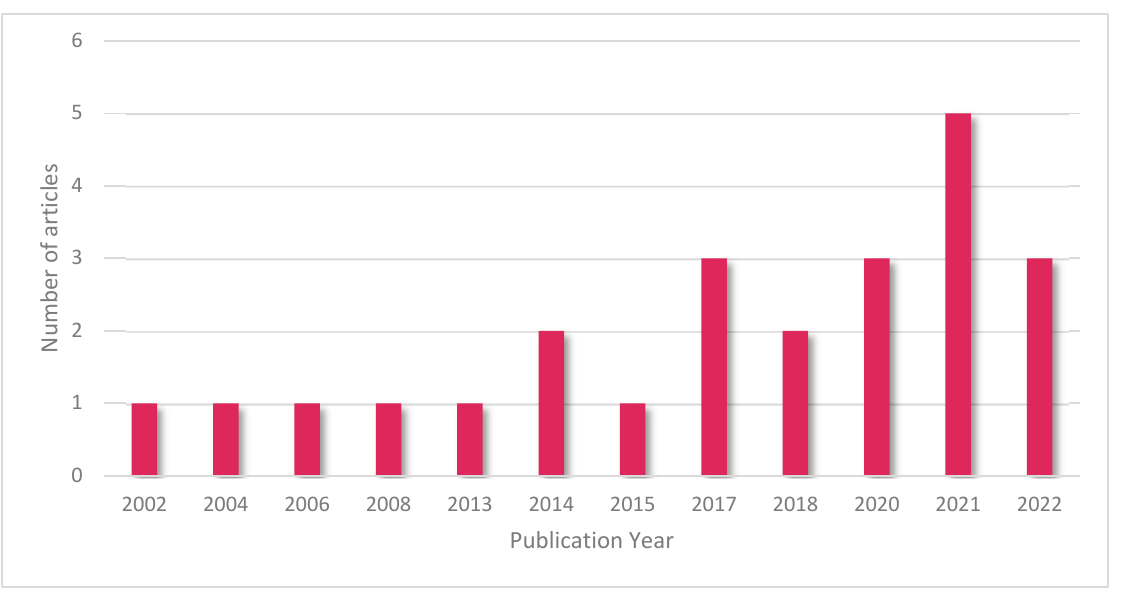
Figure 4. Illustration of number of included articles based on publication year.